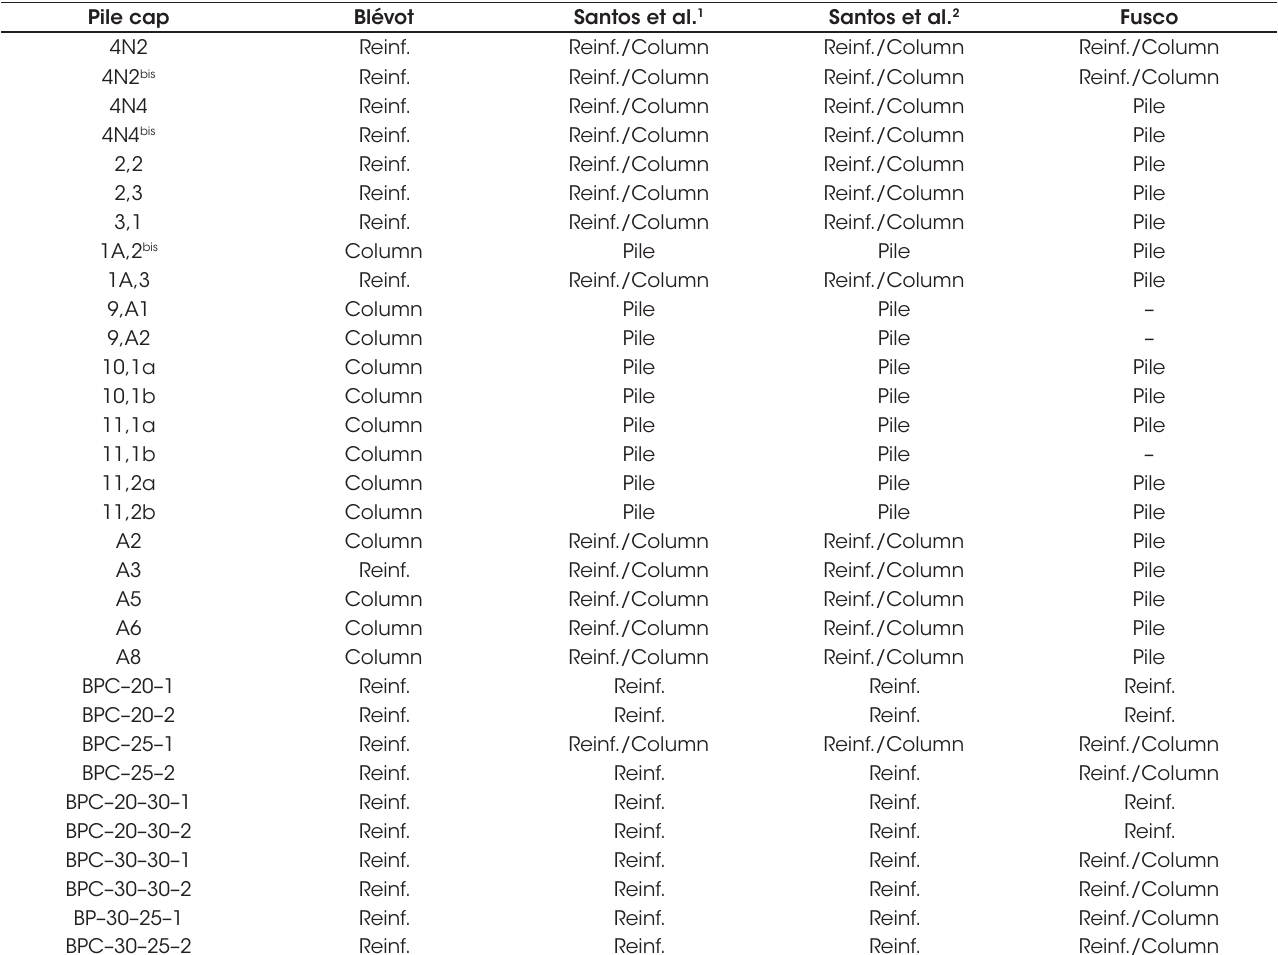
Table 4 Failure modes predicted by Blévot, Fusco e Santos et al. models